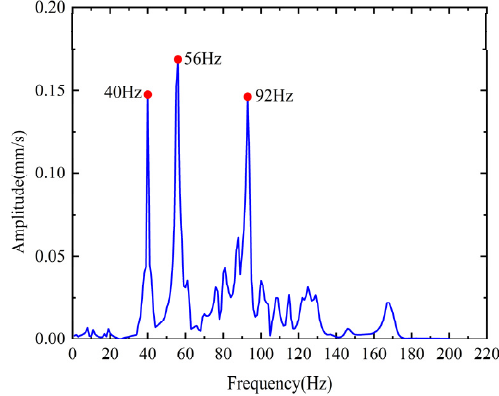
Figure 10. Axial vibration characteristic curve .